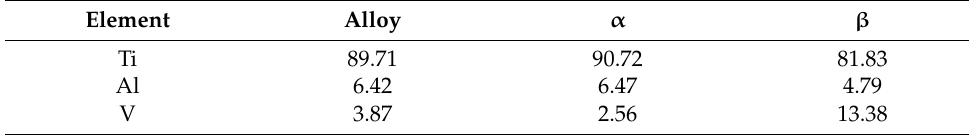
Table 1. EDXS analyses results in %wt. (Figure